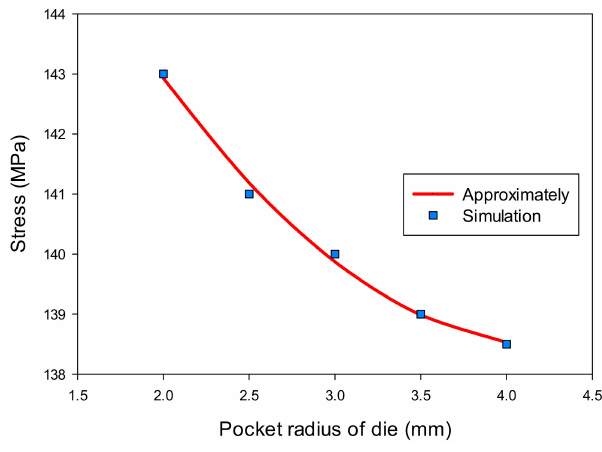
Figure 14. The effect of pocket radius of die on stress.